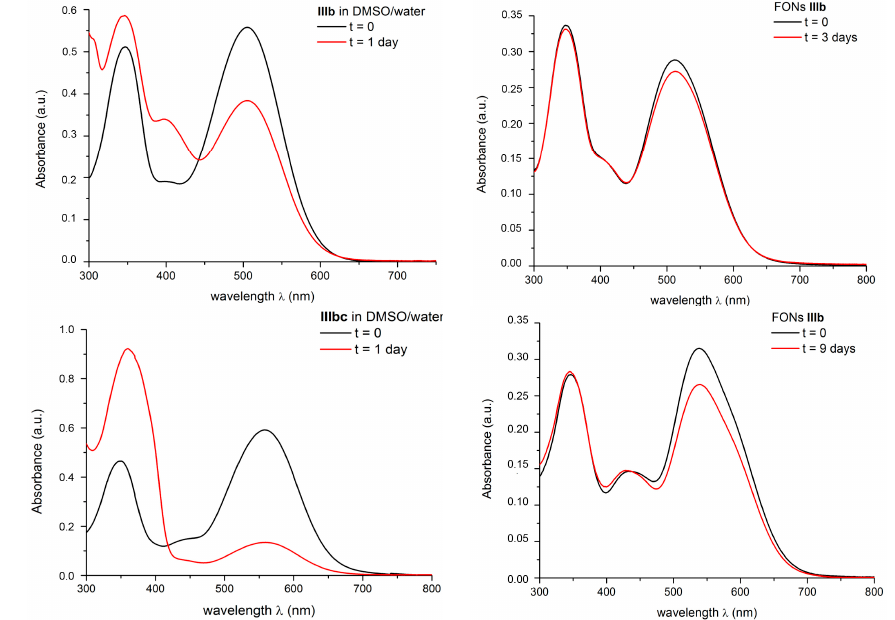
Figure 10 . Chemical stabilization of dyes IIIb and IIIc within FONs. Figure 10. Chemical stabilization of dyes IIIb and IIIc within